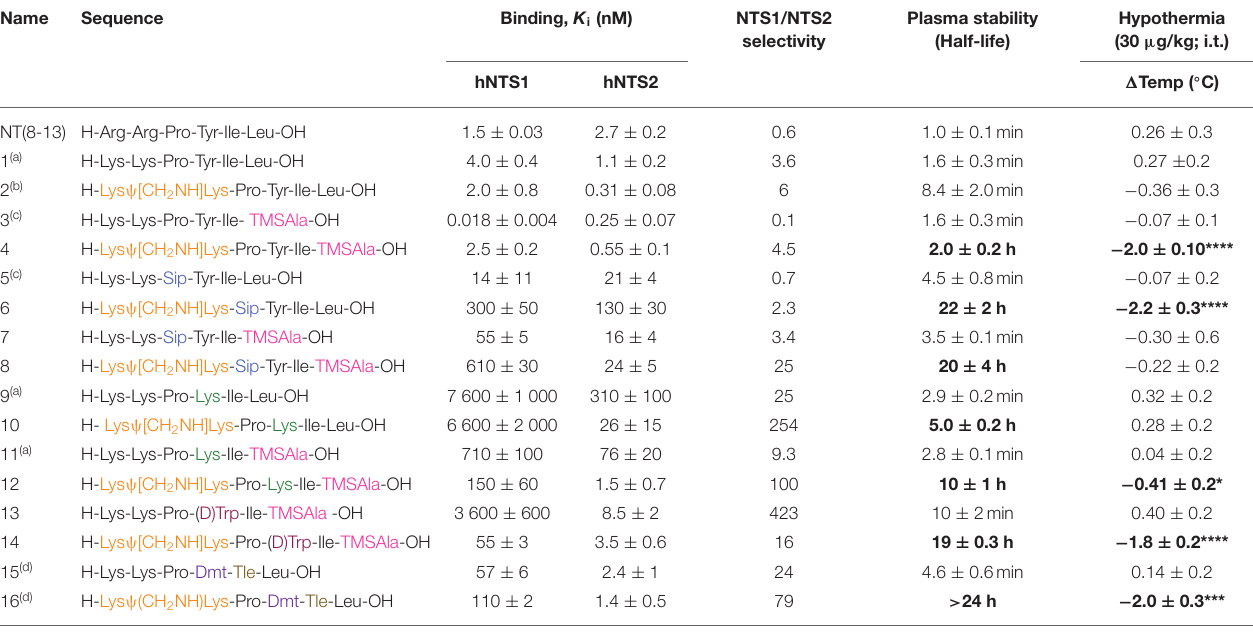
TABLE 2 | Binding affinities toward the hNTS1 and hNTS2 receptors, plasma stability and body temperature of NT(8-13) and its derivatives.